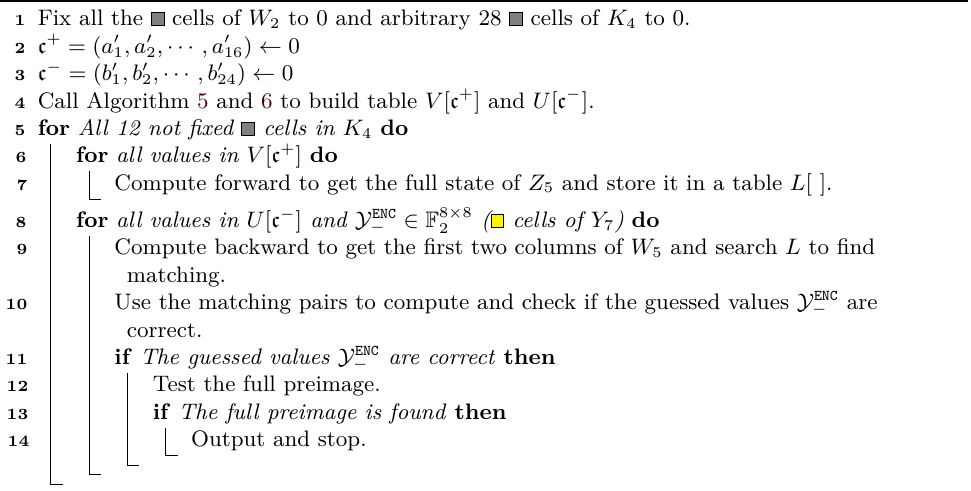
Algorithm 7: The MITM preimage attack on 7.5-round Streebog-256 compres- sion